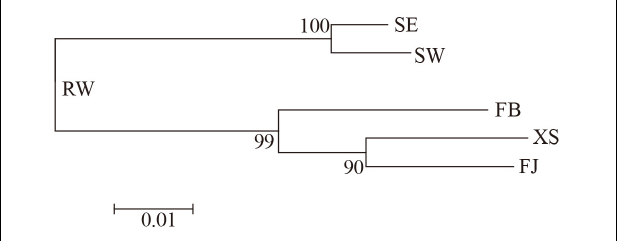
FIGURE 3 | Neighbor-joining phylogenetic tree based on genetic distance among the farmed and spontaneous populations of Saccharina japonica from a kelp farm in China. The bar indicates the genetic